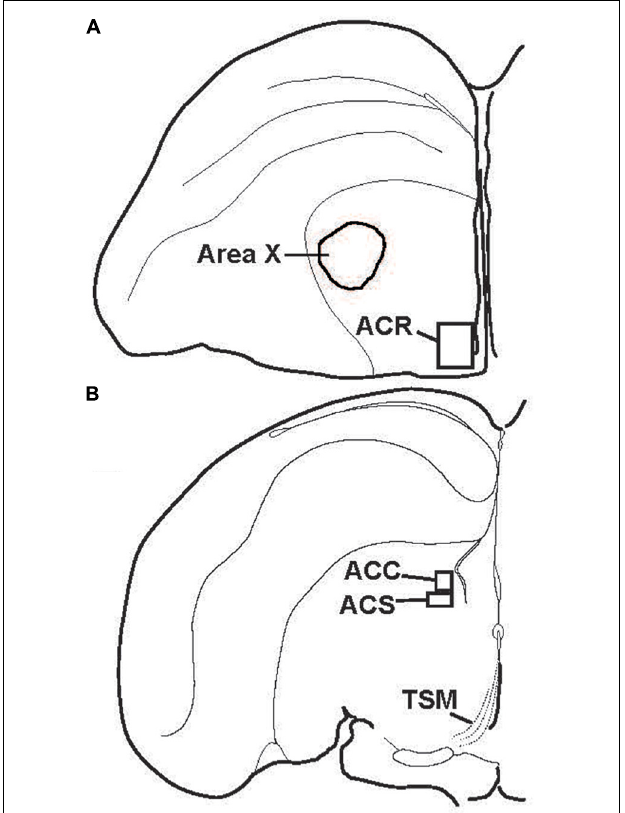
FIGURE 3 | Location of subdivisions of the songbird NAc. Illustrations showing locations of (A) the rostral pole of the nucleus accumbens (ACR) and (B) the nucleus accumbens core (ACC) and shell (ACS) in the left hemisphere of coronal sections. TSM = tractus septomesencephalicus.